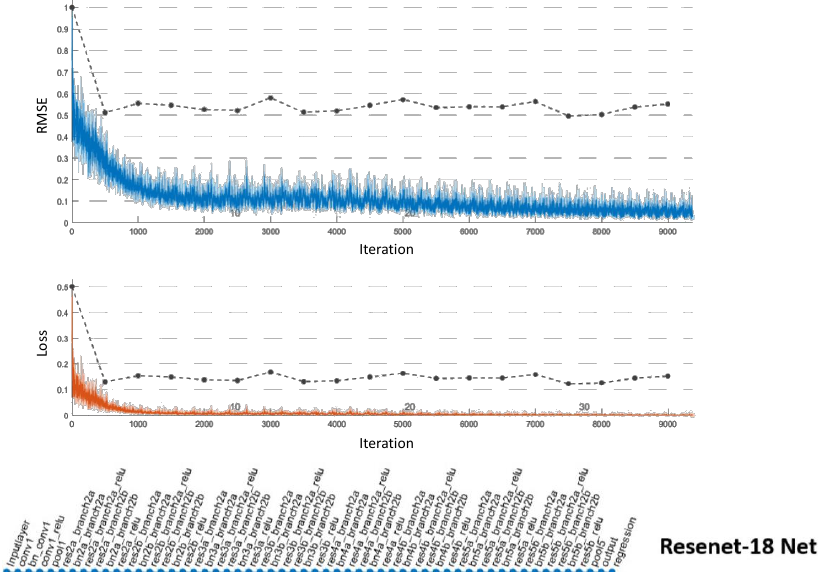
Figure 10. Resnet-18: configured with a learning rate of 10 − 1 , piece-wise scheduling, and 50 Epochs. Terminated early in 77 min and a final RMSE of 0.55 with clear signs of